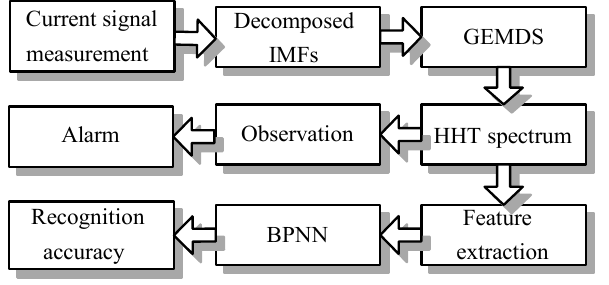
Figure 1. Structure of bearing damage detection using the proposed greedy empirical mode decomposition (GEMD).